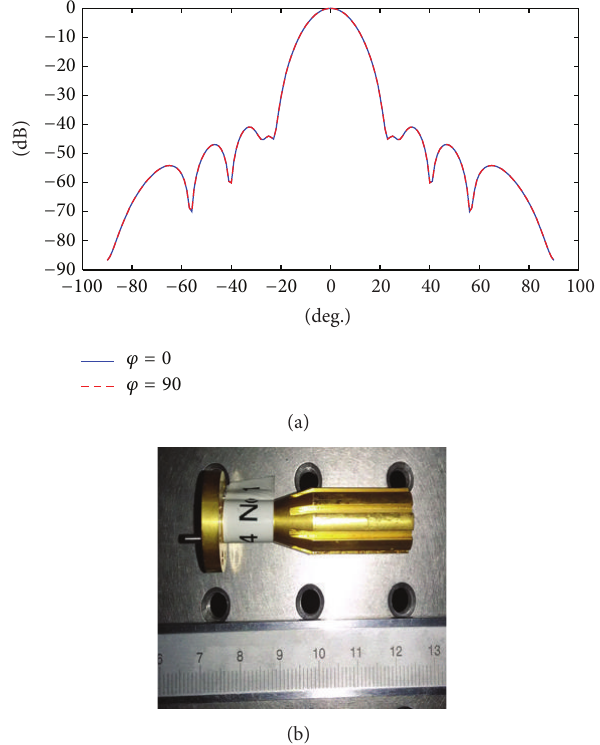
Figure 10: 325 GHz corrugated horn: (a) predicted far field pattern; (b) fabricated prototype.